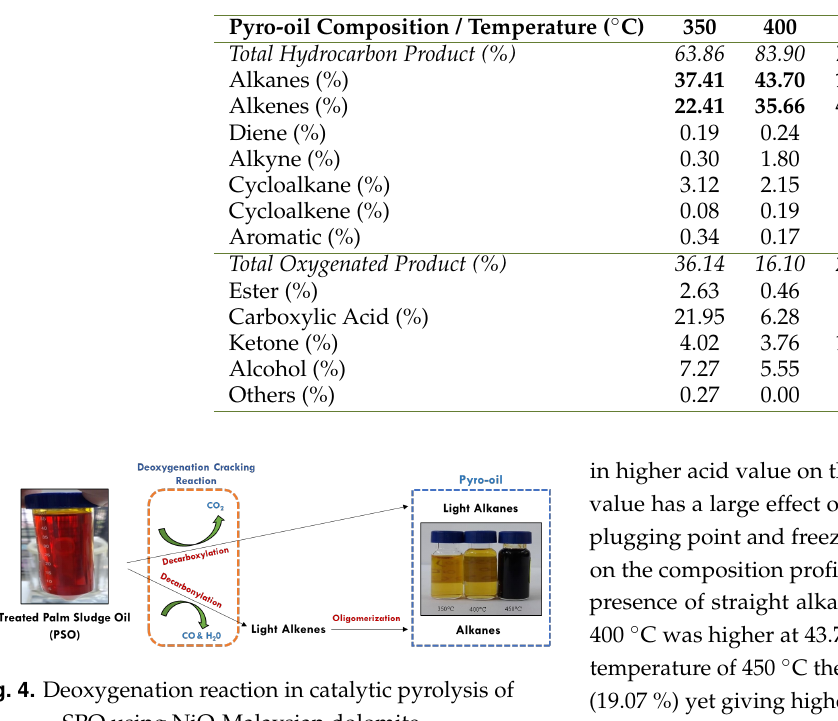
Table 1. Composition of pyro-oil at different temperature (reaction time: 30 minutes, N 2 : 100 ml/min, 5wt.% Nickel dolomite catalyst: 150g SPO).